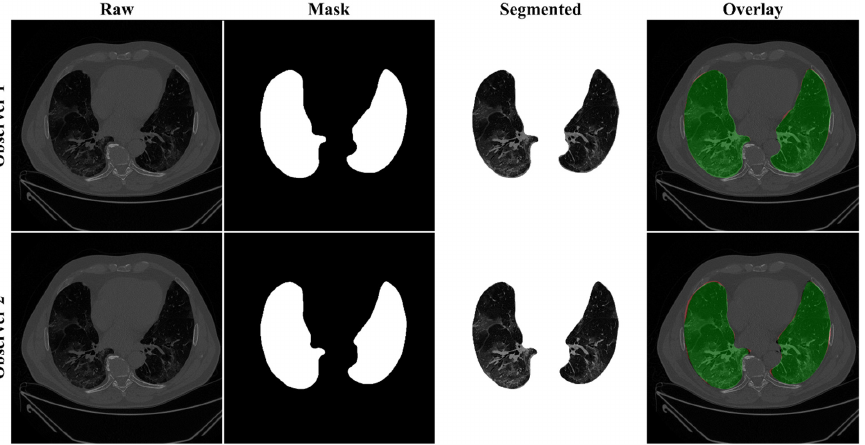
Figure 8. Results from VGG-SegNet while using Observers 1 and 2. Columns are the raw, binary mask output, segmented lung region, and overlay of the estimated lung region vs. ground truth region.